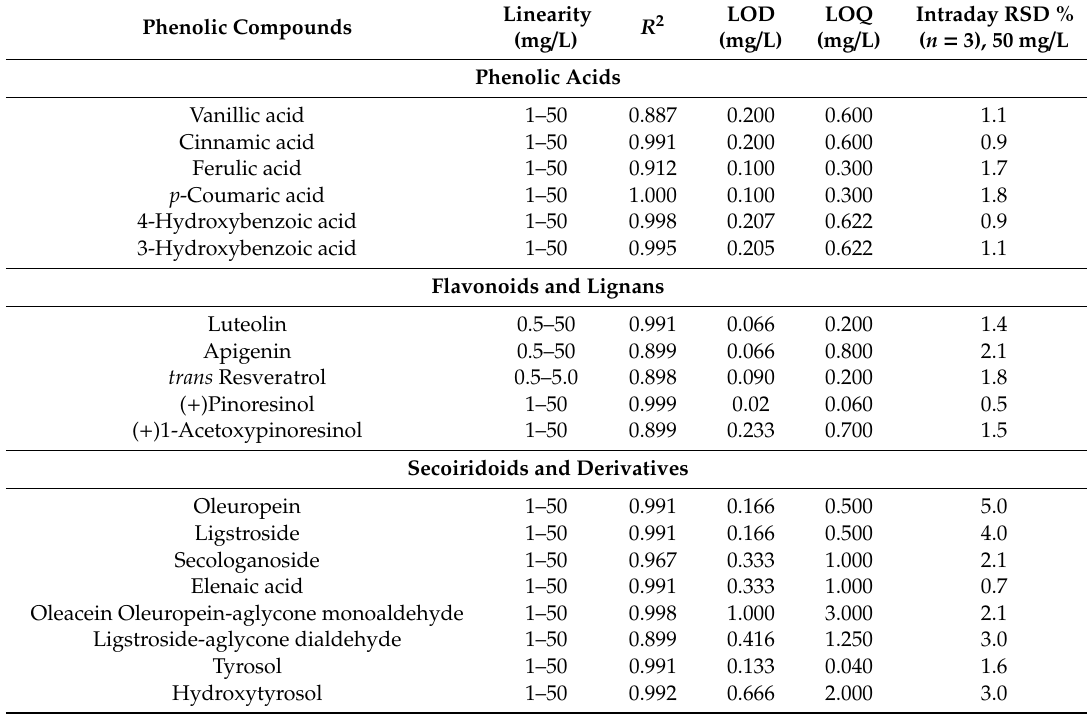
Table 1. Validation parameters of the Ultra-High-Performance Liquid Chromatography (UHPLC)–MS / MS method of analysis.